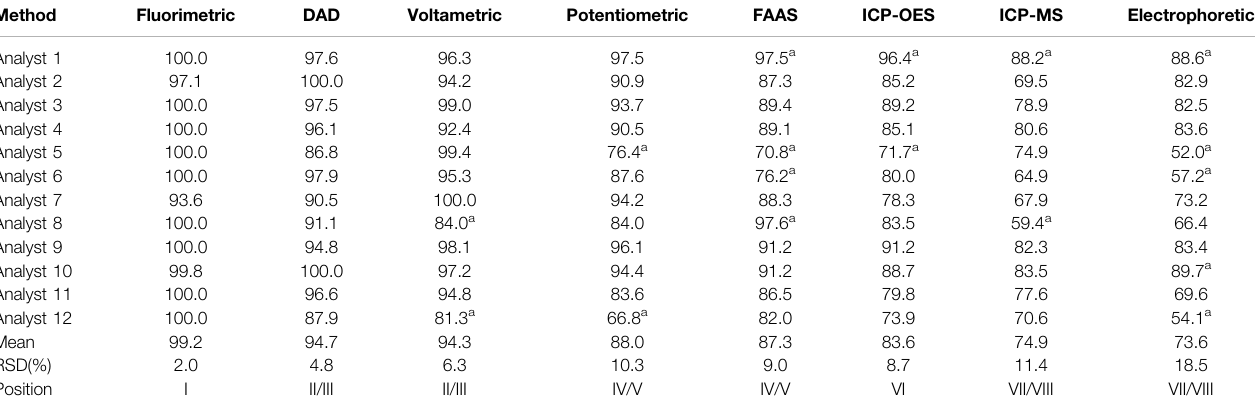
TABLE1| Theoverallassessmentvaluesfortheindividualmethodsaccordingtoallevaluatingpeople,includingmeanvalues,RSD,andtheresultingposition intheranking.